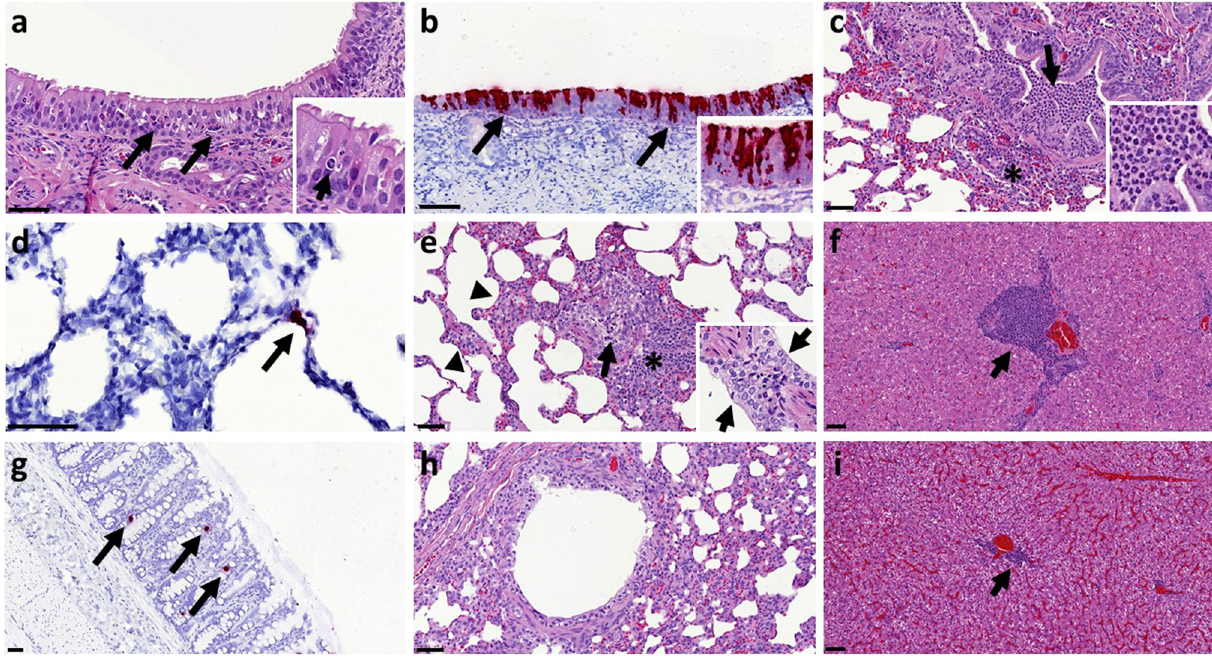
Fig. 4 Histopathological fi ndings and presence of SARS-CoV-2 RNA in tissue sections from ferrets inoculated with SARS-CoV-2. Two sections from each tissue or organ were evaluated independently by two quali fi ed pathologists and representative images are shown. a Nasal cavity, day 3 pc, Group 1, H&E staining. Mild epithelial cell necrosis (arrows) and minimal in fl ammatory cell in fi ltration within the epithelium; bar = 50 μ m; inset = close up image of an in fl ammatory cell within the epithelial layer. b Nasal cavity, day 3 pc, Group 1, SARS-CoV-2 viral RNA detection (RNASCope staining). Presence of viral RNA in abundant epithelial and sustentacular cells from the nasal cavity mucosa; bar = 50 μ m; inset = close up image showing abundant viral RNA within the olfactory epithelium. c Lung, day 5 pc, Group 1, H&E staining. Moderate bronchopneumonia with neutrophil and macrophage in fl ammatory in fi ltrate within the bronchiolar lumina (arrow). Mild peribronchiolar in fi ltration of mononuclear cells (*); bar = 50 μ m; inset = clse up image of the bronchiolar in fl ammatory cell in fi ltration showing abundant neutrophils. d Lung, day 3 pc, Group 2, SARS-CoV-2 viral RNA detection (RNASCope staining). Presence of viral RNA in type II pneumocyte (arrow); bar = 50 μ m. e Lung, day 21 pc, Group 1, H&E staining. A Bronchiole with mild in fl ammatory in fi ltration in the lumina (arrow) and attenuation of the epithelial cells. Moderate peribronchiolar in fi ltration of mononuclear cells (*) and mild interalveolar septal in fl ammatory cell in fi ltration with thickening of the wall (arrowheads); bar = 50 μ m; inset = close up image of mils pneumocyte II proliferation in the lung at day 7 pc. f Liver, day 21 pc, Group 1, H&E staining. Moderate multifocal hepatitis with mononuclear cell in fi ltration in the portal areas (arrow); bar = 50 μ